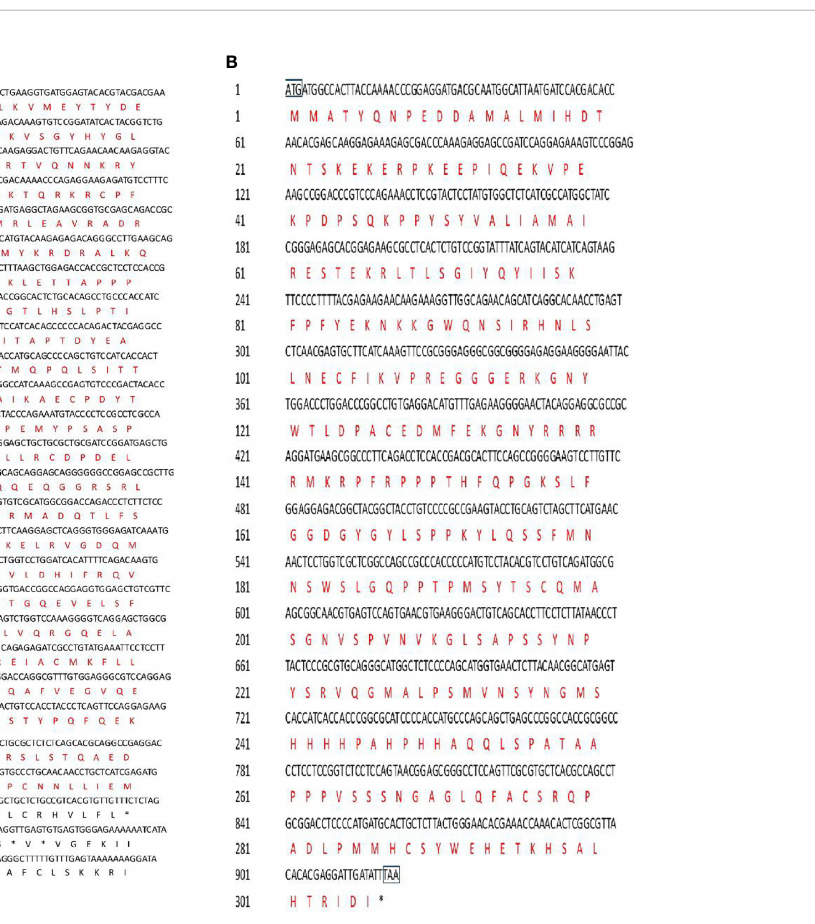
FIGURE 1 | Nucletide and amino acid sequences of C. undulates SF-1 and FOXL2 . (A) Nucletide and amino acid sequences of C. undulates SF-1 . The black box marks the start codon ATG and the stop codon TGA. The black typeface is the nucleotide sequence, the red typeface is the amino acid sequence. (B) Nucletide and amino acid sequences of C. undulates FOXL2 . The black box marks the start codon ATG and the stop codon